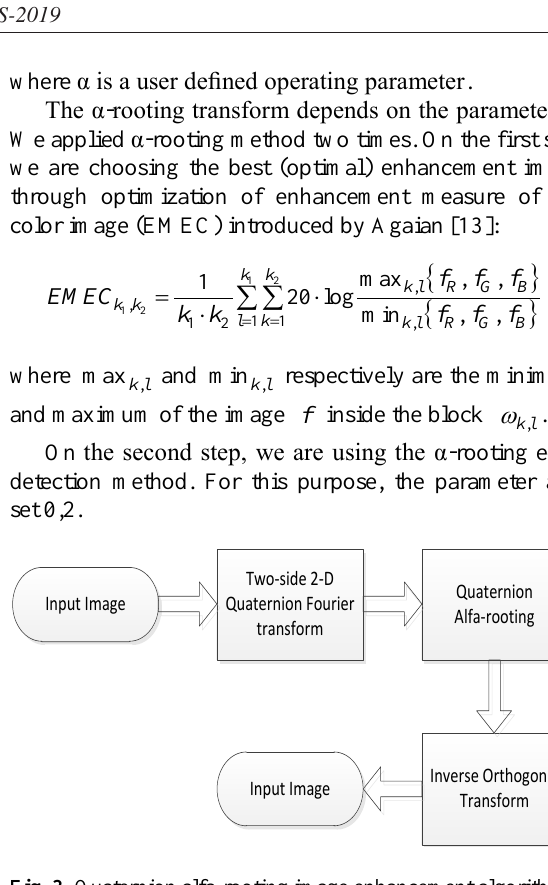
Fig. 3. Quaternion alfa-rooting image enhancement algorithm.